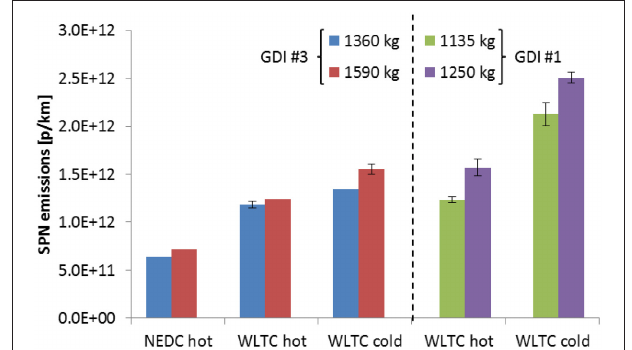
FIGURE 5 | The effect of ambient temperature on SPN emissions. Error bars indicate the minimum and maximum emissions of three test repetitions. Tests were conducted in the laboratory with PMP-CVS equipment.